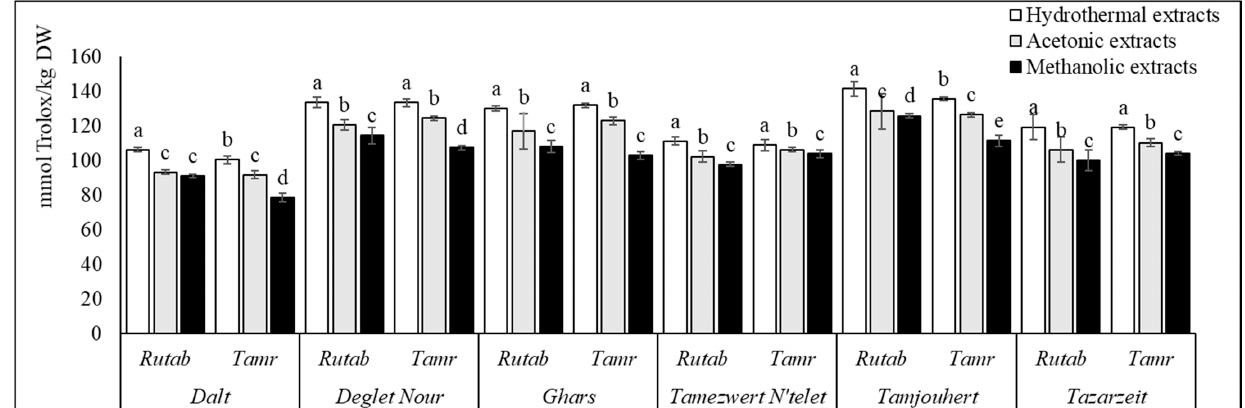
Figure 4. Ferric reducing power of all cultivars and ripe stages for the three extraction systems. Values are mean ± SD. Different letters indicate that the results are statistically different ( p < 0.05, b < a ).